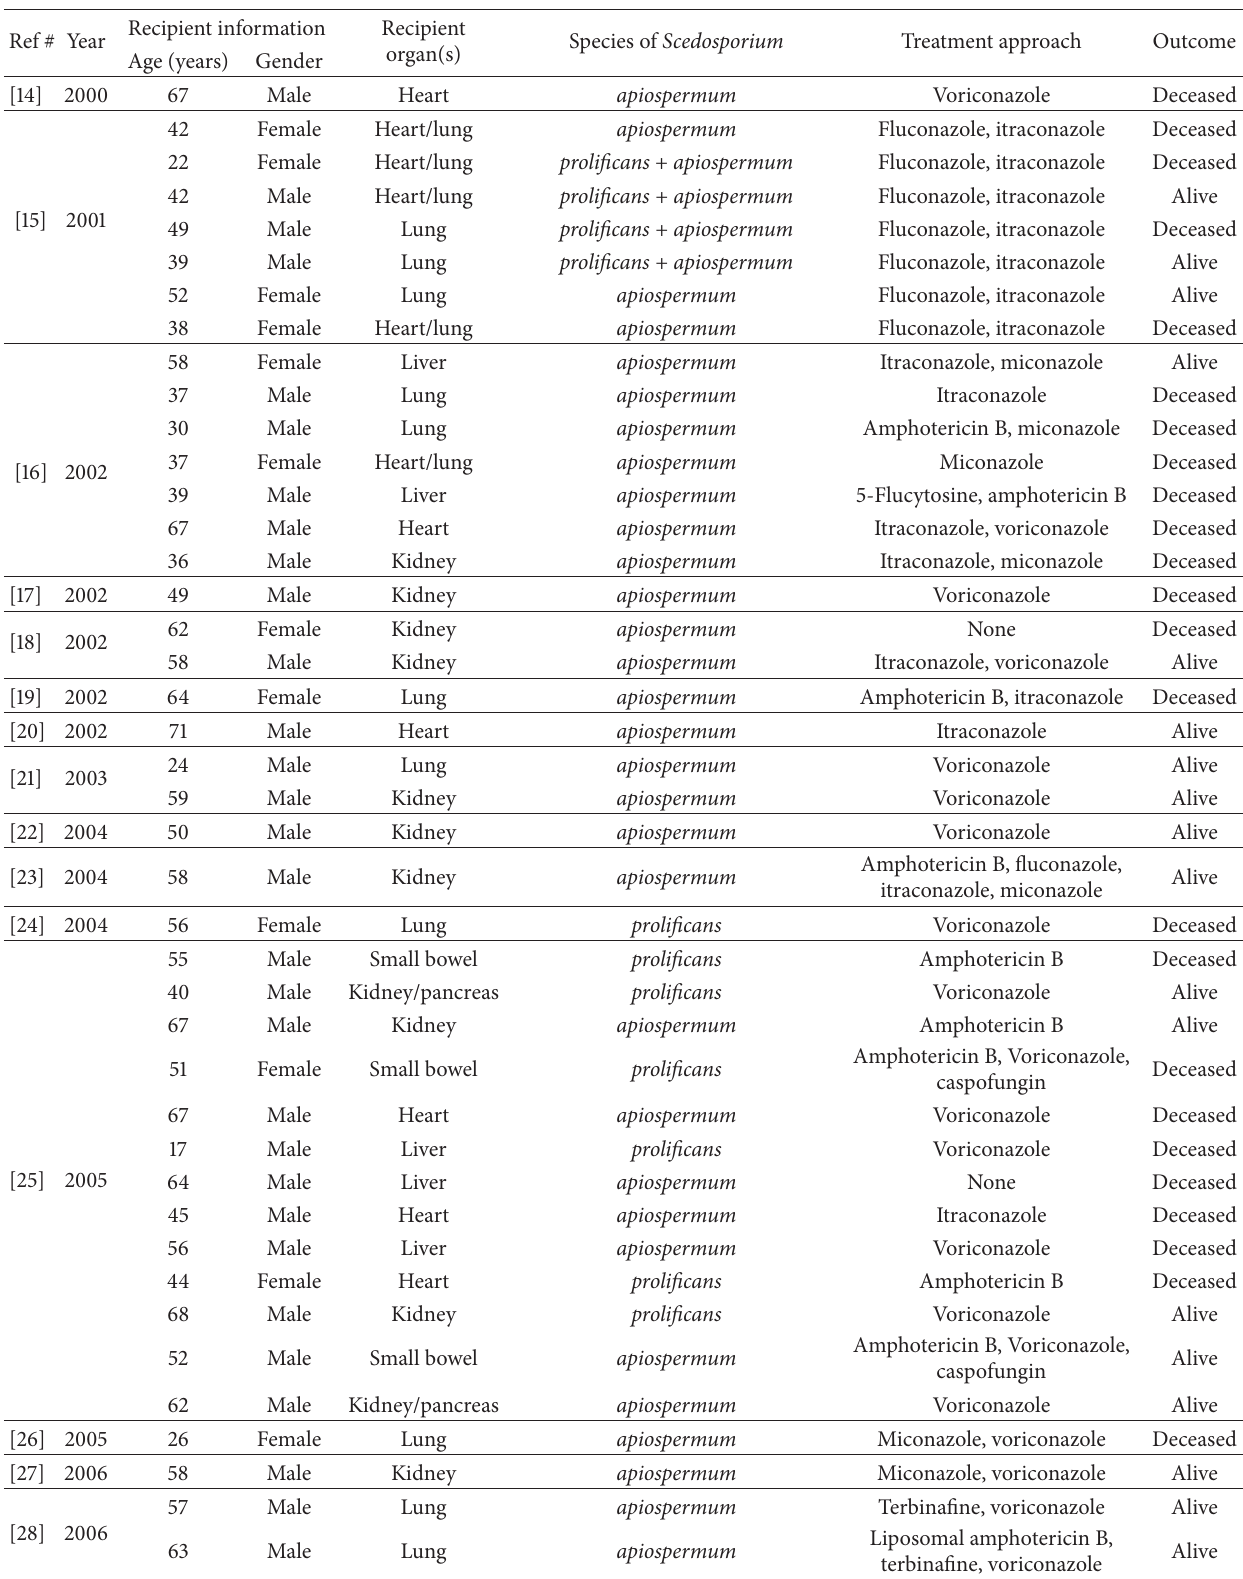
Table 3: Review of solid organ transplant-associated Scedosporium